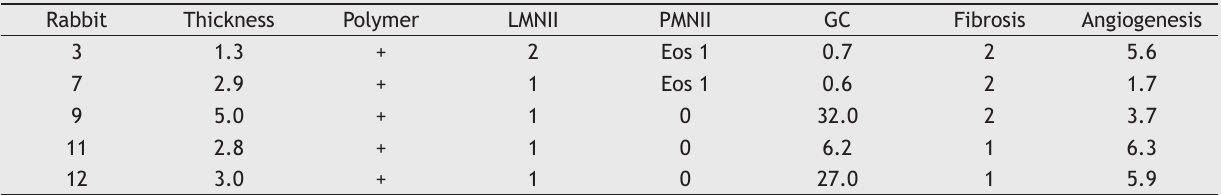
Table 3 Histological characteristics found in Group II - 90 days - Vocal fold with biopolymer. Rabbit Thickness